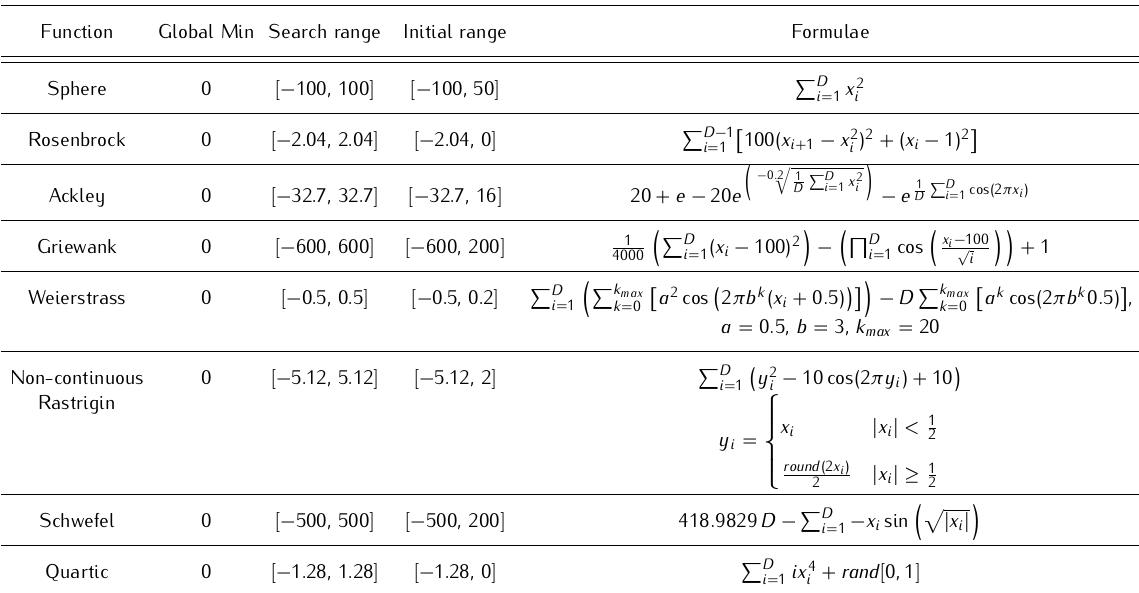
Table 1. Benchmark functions